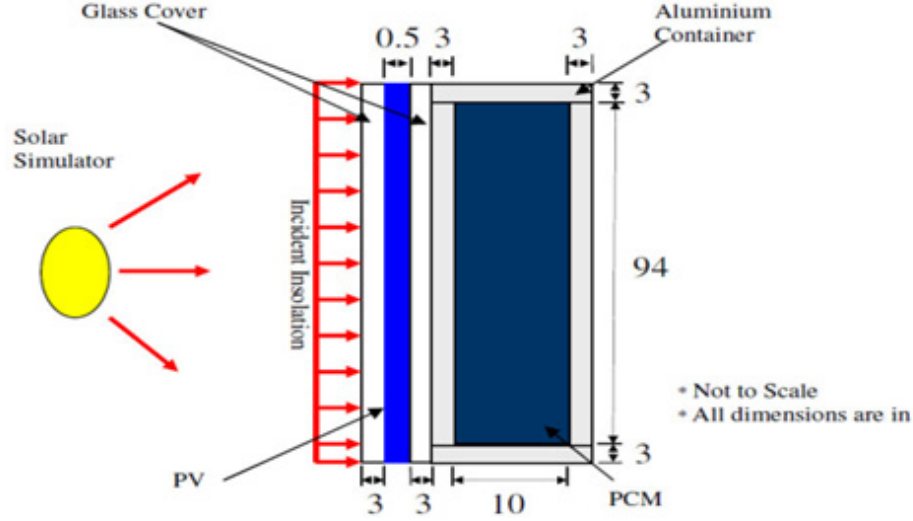
Figure 7. Diagram of the experimental setup presented by Ren et al. [27].